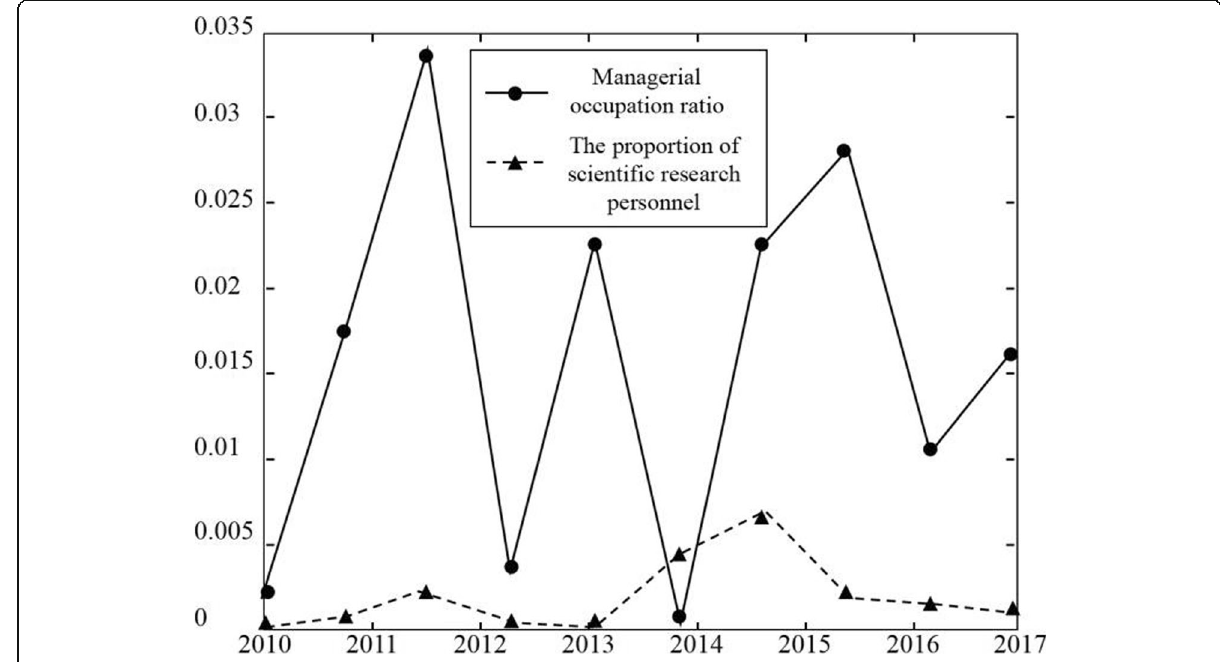
Fig. 6 Network error change diagram